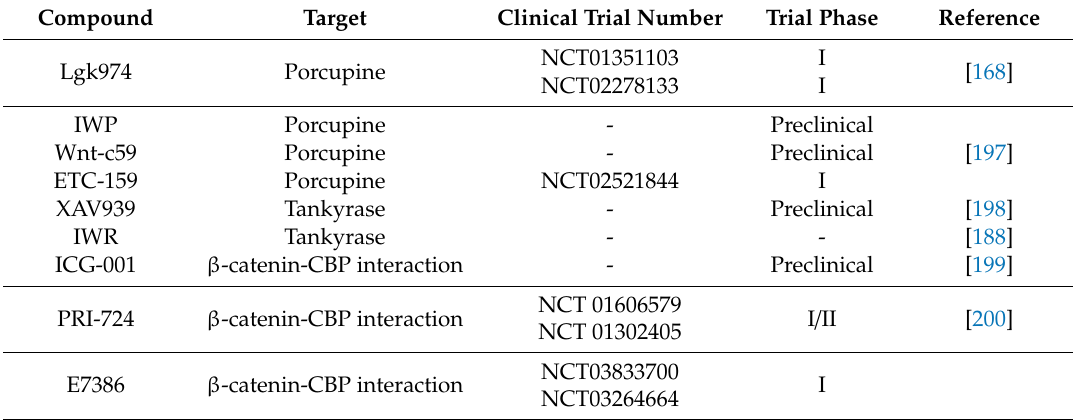
Table 1. Potential Inhibitors Targeting the Wnt Signaling Pathway in Preclinical and Clinical